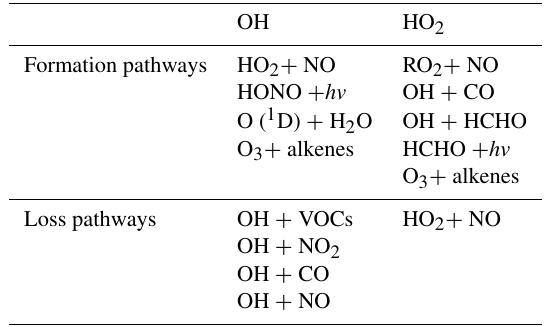
Table 2. Formation and loss pathways of OH and HO 2 considered in this